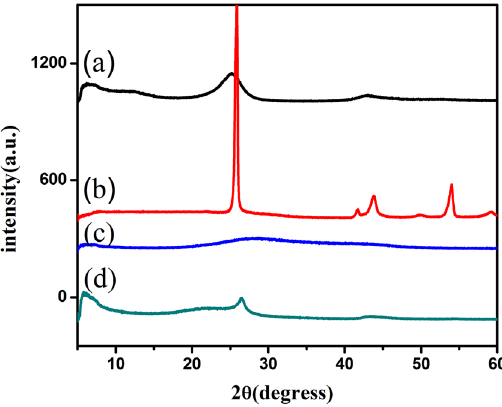
Figure 3. XRD patterns of ( a ) acetylene black, ( b ) anode graphite, ( c ) graphite oxide and ( d ) graphene.